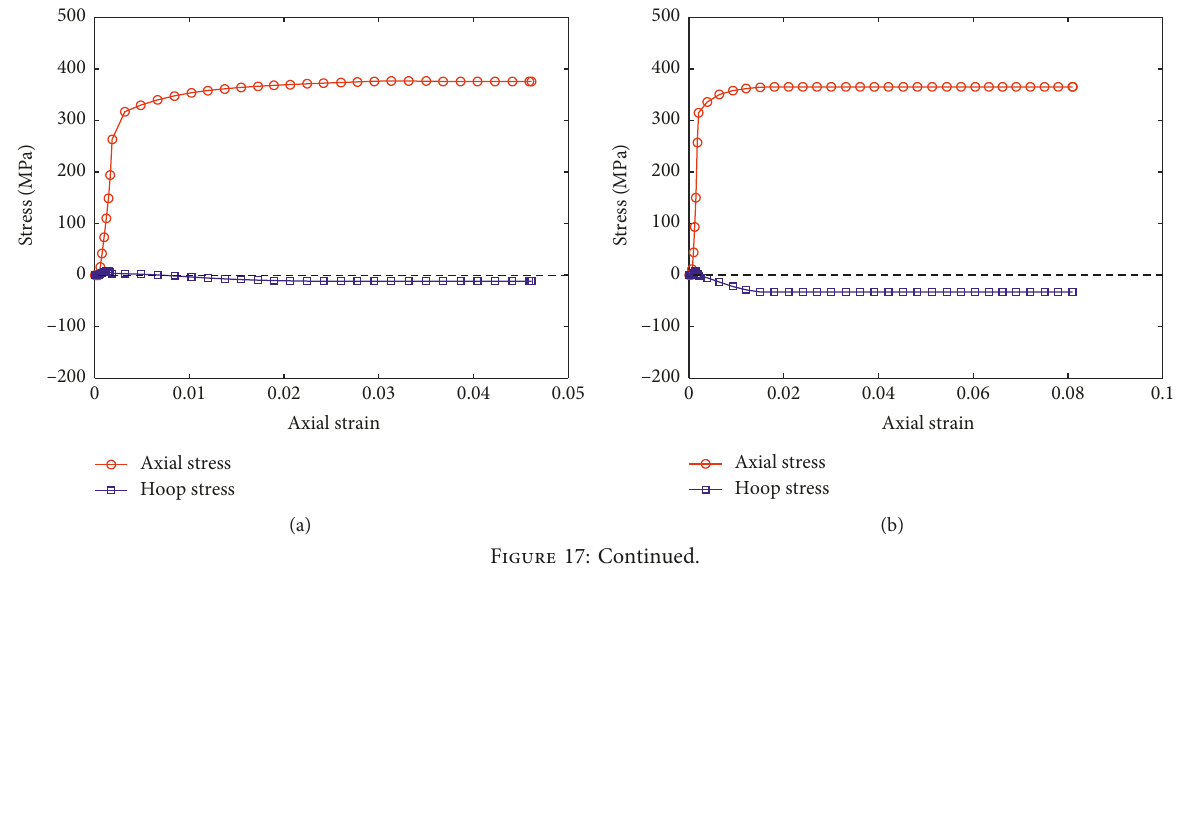
� 4mm; Type A steel tube). (b) A4-F60-M1 ( θ � ± 60 ° ; frp � 4 mm; Type A steel frp